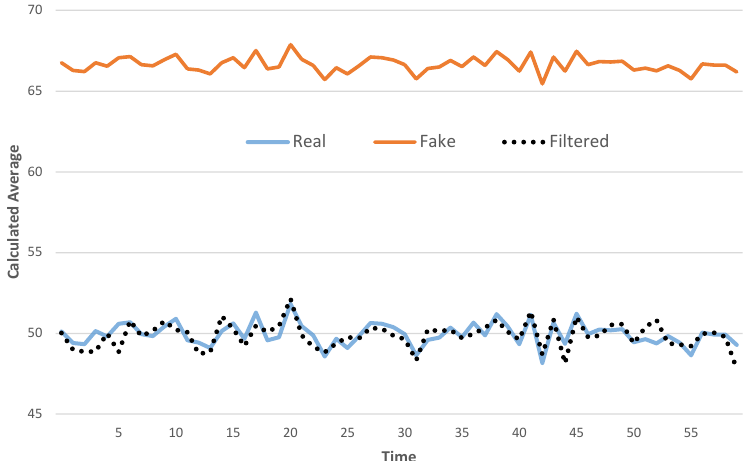
Figure 2. Impact of an active attacker that generates fake measurements with a valid signature. The blue line indicates the correct value that a device would have calculated if there was not an attack. The orange line indicates the estimated value if no defense is considered. The black dotted line indicates the estimated value if duplicate public keys are